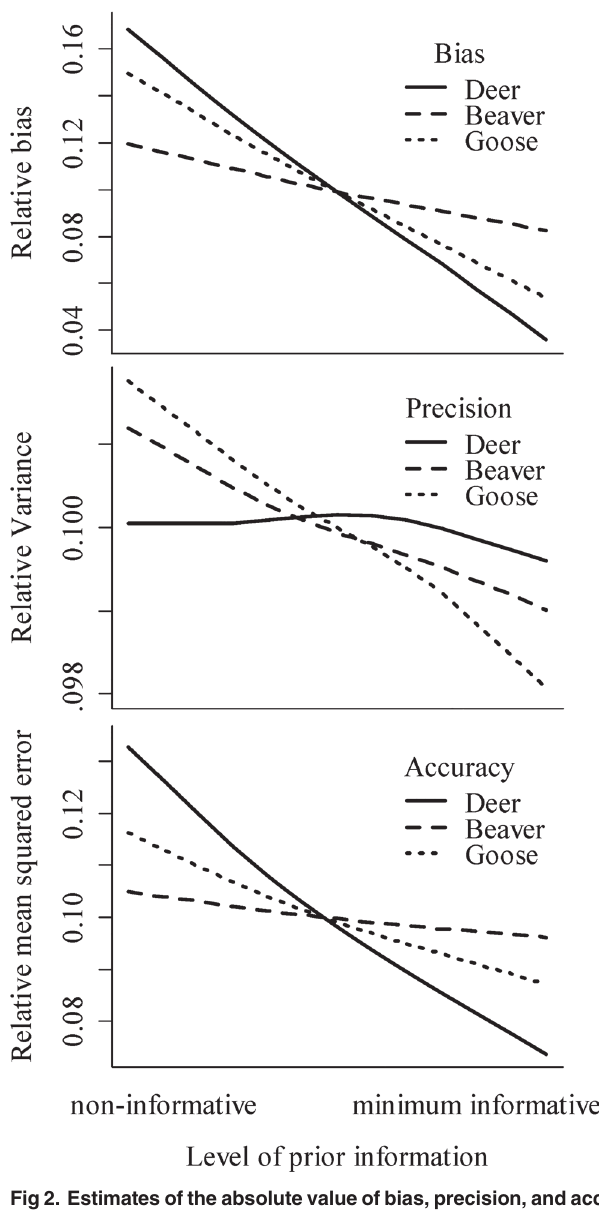
Fig 2. Estimates of the absolute value of bias, precision, and accuracy of parameter estimates from Bayesian stable isotope mixing models with varying levels of priors (i.e., from non-informative to the minimum informative prior). Parameters represent the proportional contributions of white-tailed deer, beaver, and Canada goose to the diet of gray wolves ( n = 10) during a captive feeding study located at the Wildlife Science Center, Forest Lake, Minnesota, USA, 2011 – 2012. Mixing models were based on wolf discrimination factors estimated from this study. Non-informative priors correspond to a Dirichlet distribution with α vector of 1, 1, 1. Minimum informative priors represent the vaguest priors where SIMM posteriors were not statistically different from estimated proportions, with Dirichlet distribution α vector of 13, 1,